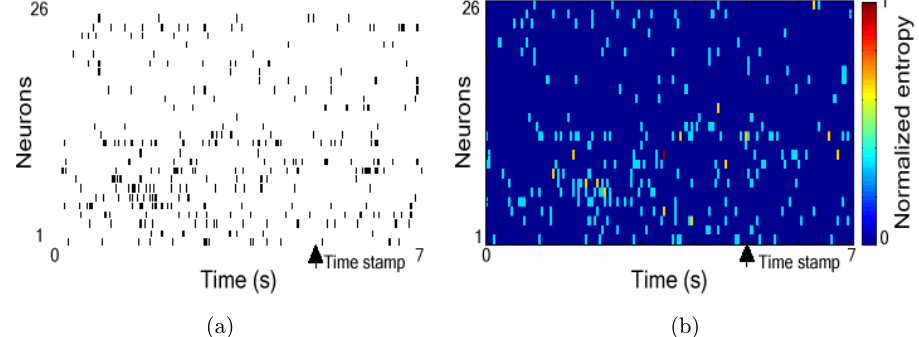
Fig. 1. Neuronal population activity: (a) Spatio-temporal spike trains. (b) Mapping of the neuronal population ¯ring entropy. The tripping time by infrared in Y-maze is indicated by an